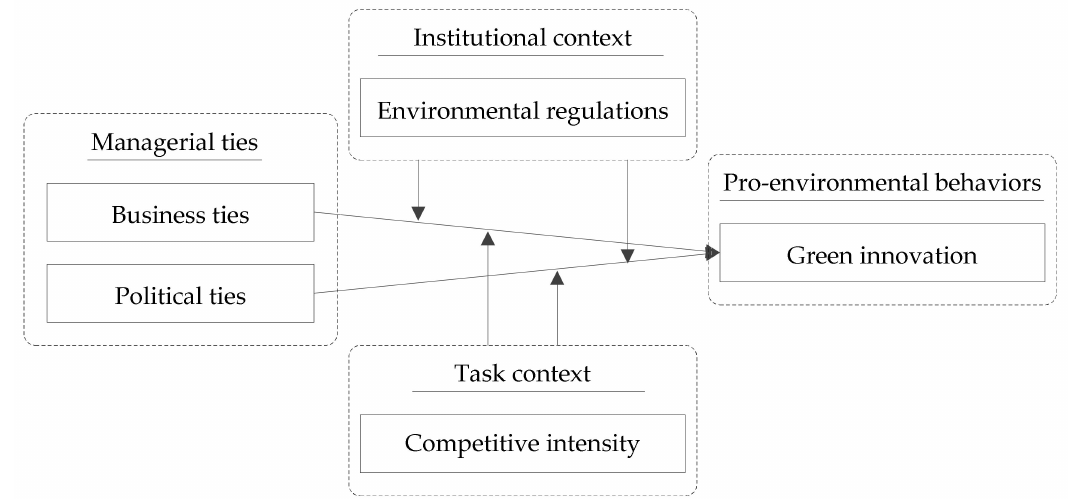
Figure 1. Conceptual